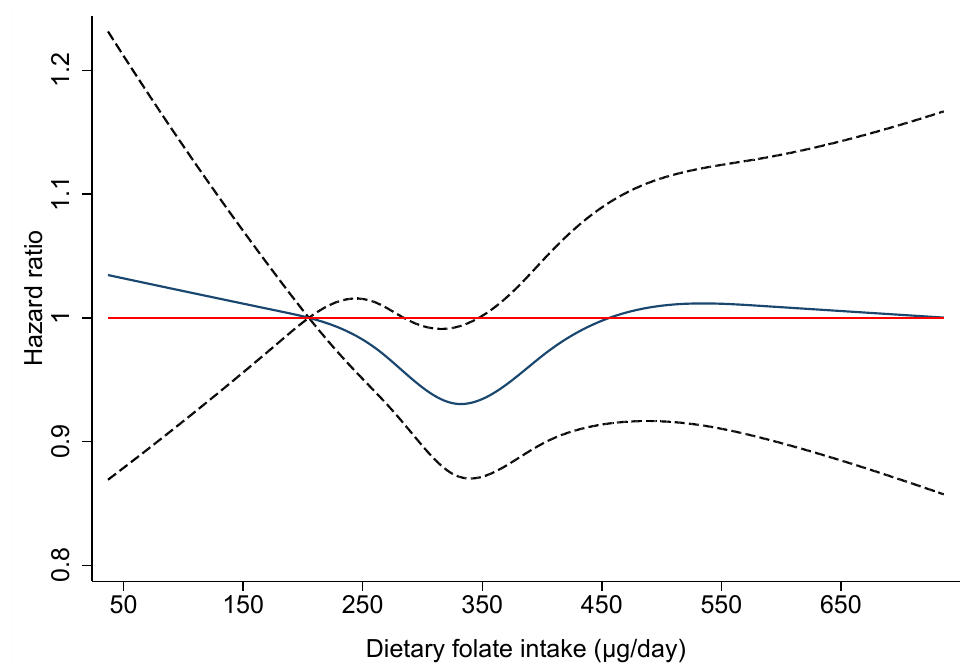
Figure 2. Non-linear relationship between dietary folate intake and breast cancer risk (solid line: hazard ratio; dotted line: 95% confidence intervals) among 318,686 women in the EPIC cohort, obtained by using five-knots cubic splines with the median of the first quintile as a reference value (205 µ g/day). The model was stratified by study center and one year categories of age at recruitment and adjusted for total energy intake (kcal/day), alcohol intake (g/day), dietary fiber intake (g/day), height (cm), BMI (kg/m 2 ), highest level of education (primary/no schooling, technical/professional/secondary, longer education, unknown), physical activity (inactive, moderately inactive, moderately active, active, unknown),